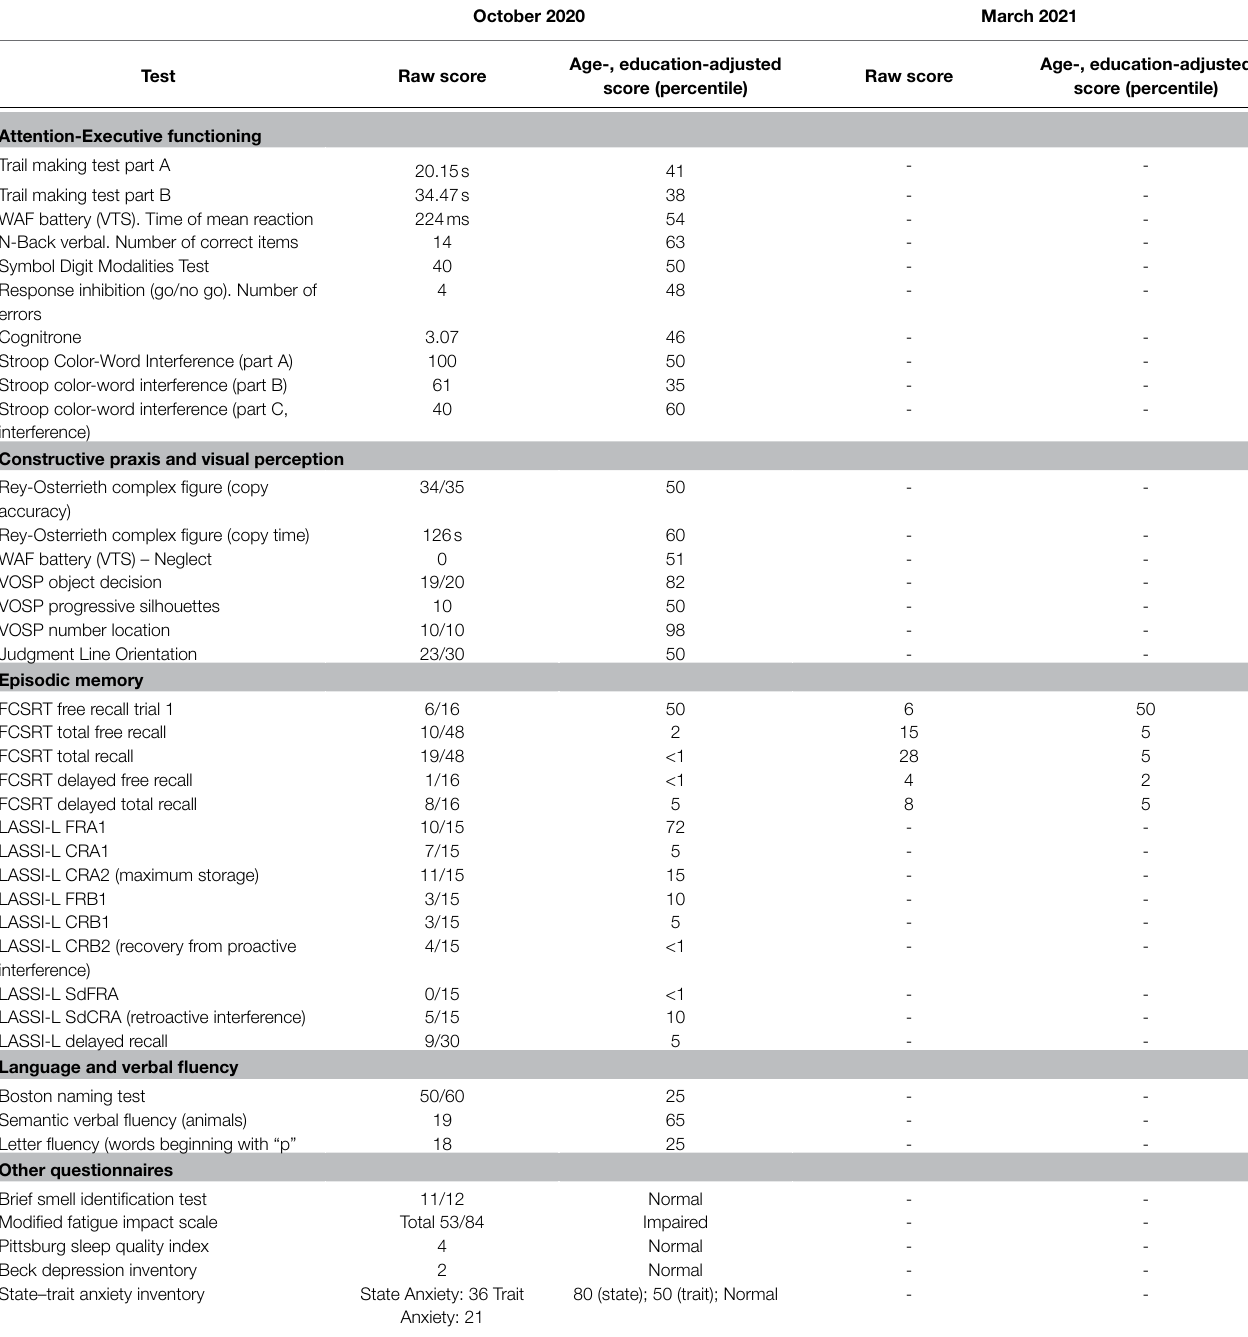
TABLE 2 | Neuropsychological assessment (67 years old, 18 years of formal